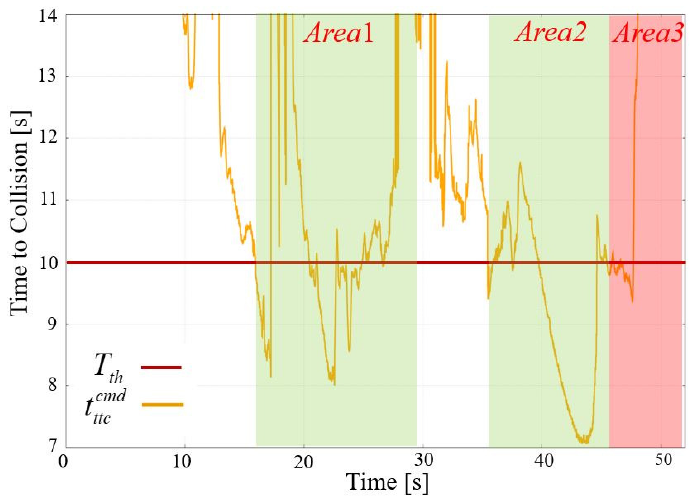
Figure 18. Experimental results of time to collision of Case 3 for Subject A.